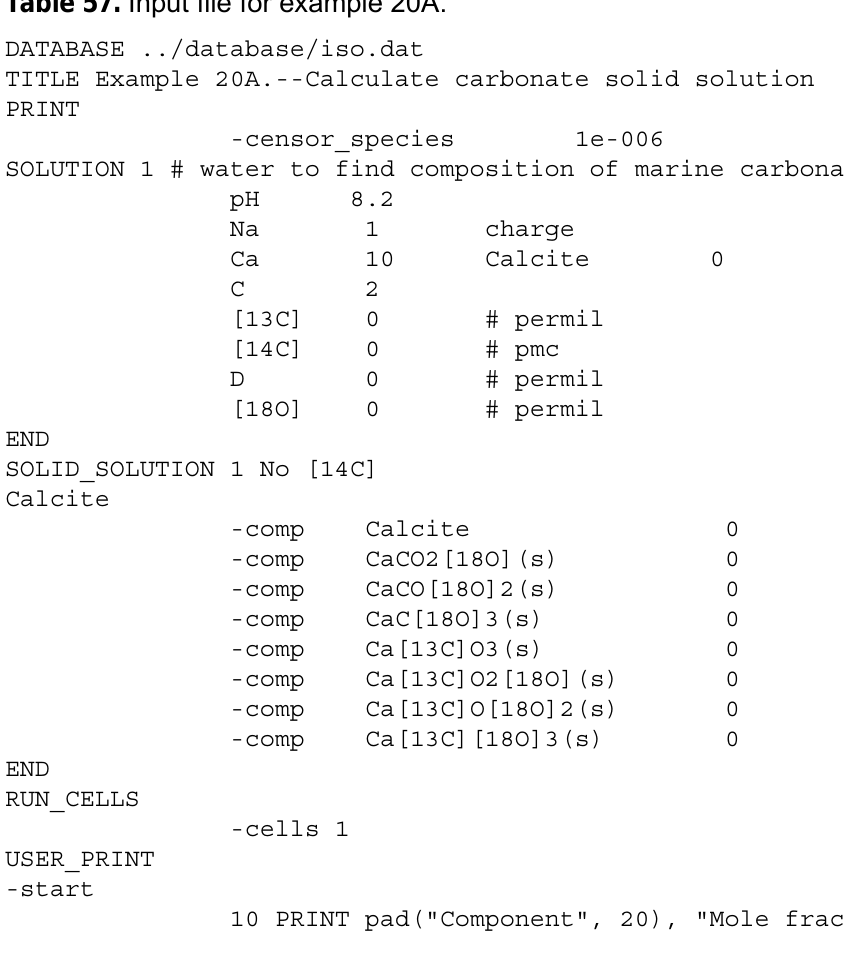
Table 57. Input file for example